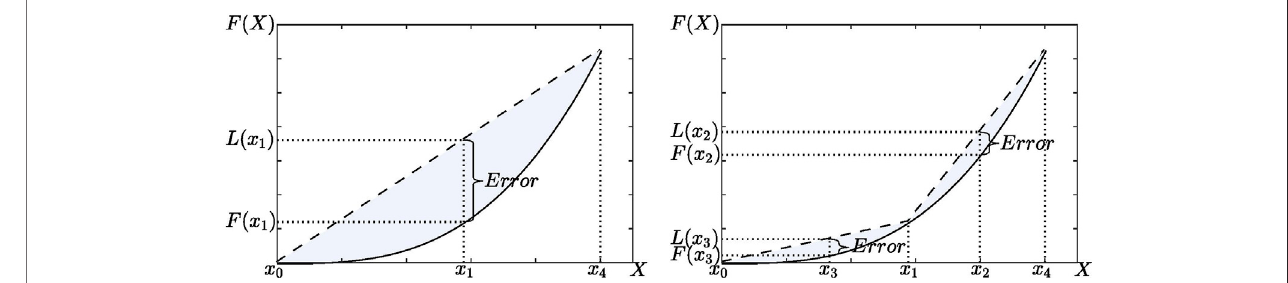
FIGURE 2 | Horizontal Modi fi cation for PWL method.